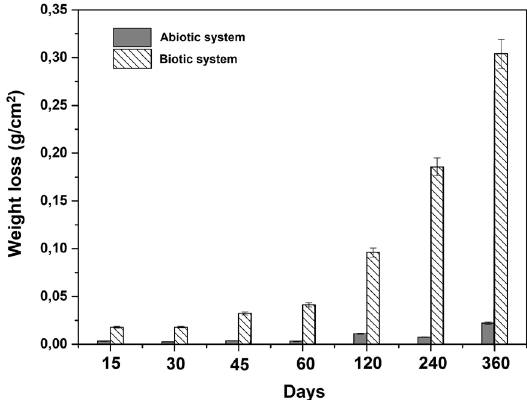
Figure 6. Weight loss of coupons X80 in produced